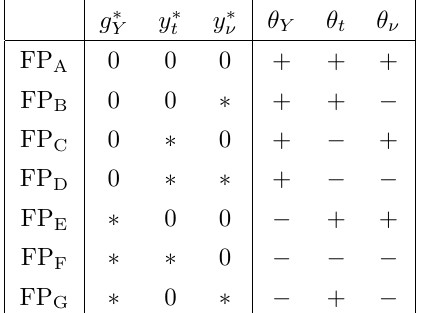
. The asterisk ν,tY